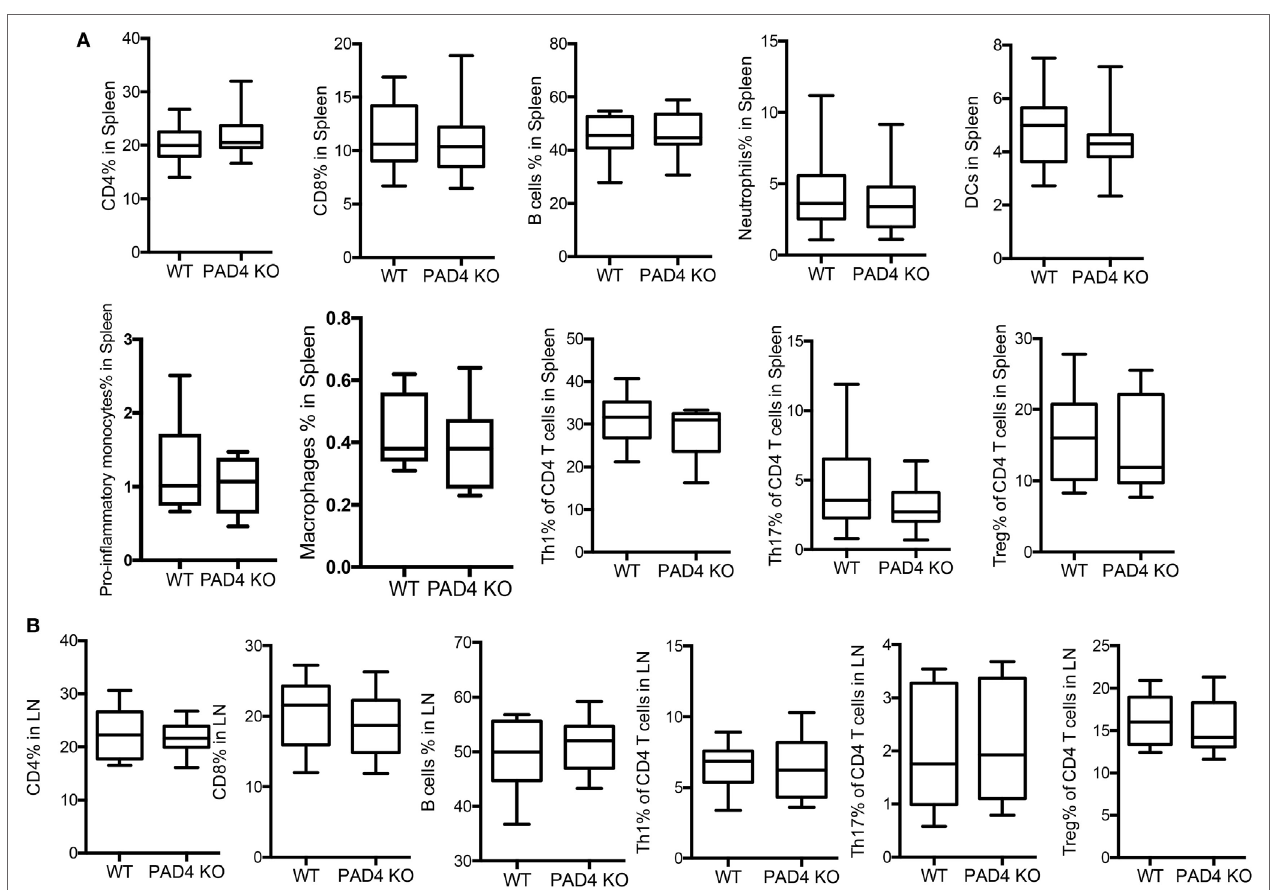
FigUre 5 | Lack of peptidylarginine deiminase 4 (PAD4) in myeloid lineage did not affect peripheral immune responses. WT and PAD4 KO mice were fed high-fat chow (HFC) for 10 weeks. (a) Percentages of CD4 + cells, CD8 + T cells, B cells, neutrophils, dendritic cells, proinflammatory monocytes ( n = 6–7/group), macrophages ( n = 6–7/group), Th1 cells, Th17 cells, and Tregs from spleens of WT and PAD4 KO mice ( n = 13–14/group from two independent experiments) p = NS. (B) Percentages of CD4 + cells, CD8 + T cells, B cells, Th1 cells, Th17 cells, and Tregs from lymph nodes (LN) of WT and PAD4 KO mice ( n = 9–10/group from two independent experiments), p =